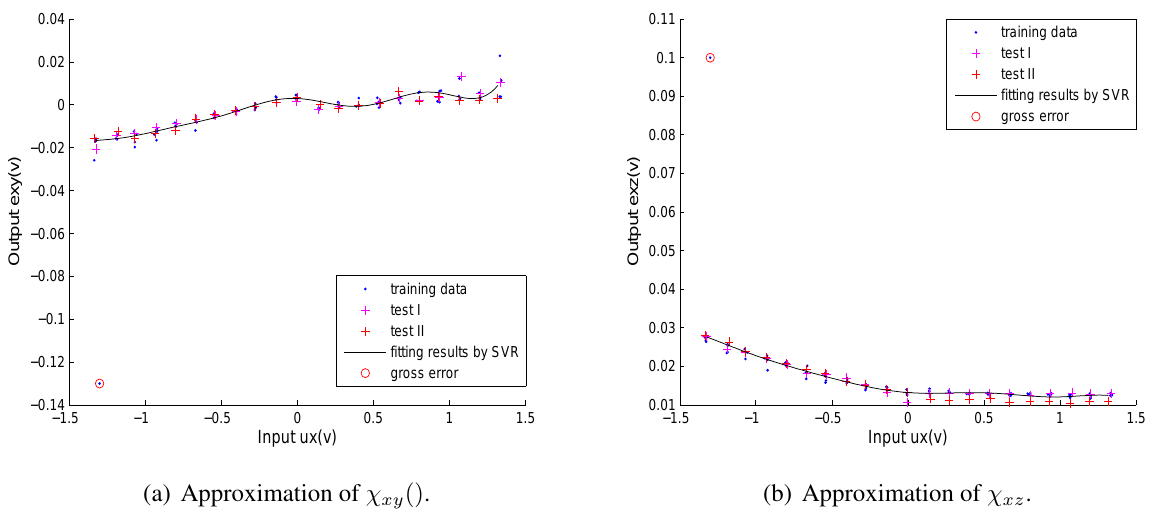
() and χ for calibration data with the gross error. xy xz